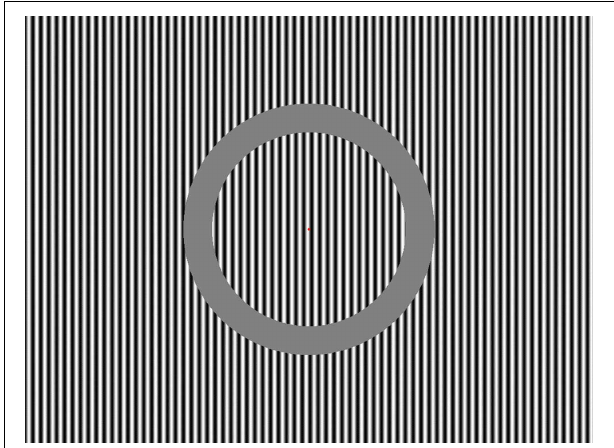
FIGURE 1 | Schematic view of the stimulus